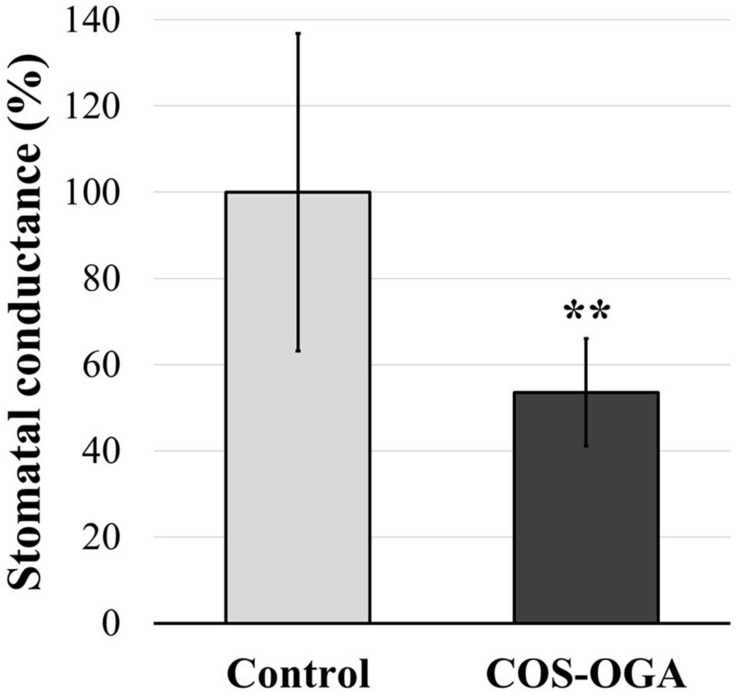
Stomatal conductance of tomato leaves after three sprayings with chitooligosaccharides–oligogalacturonides (COS-OGA; 62.5 mg/l). The average stomatal conductance of the elicited plants is expressed as a percentage of the control ± standard deviation (n = 12). **indicates a statistically significant difference to control according to Student’s t test (p < 0.01, R).